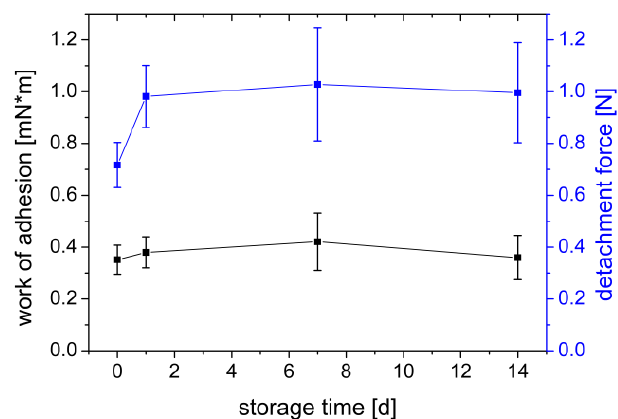
Figure 8. Influence of storage time of a gel of 2% agar and 4% mucin on work of adhesion (mN × m) and detachment force (N) measured with a PVA film. Mean ± SD, n = 6.